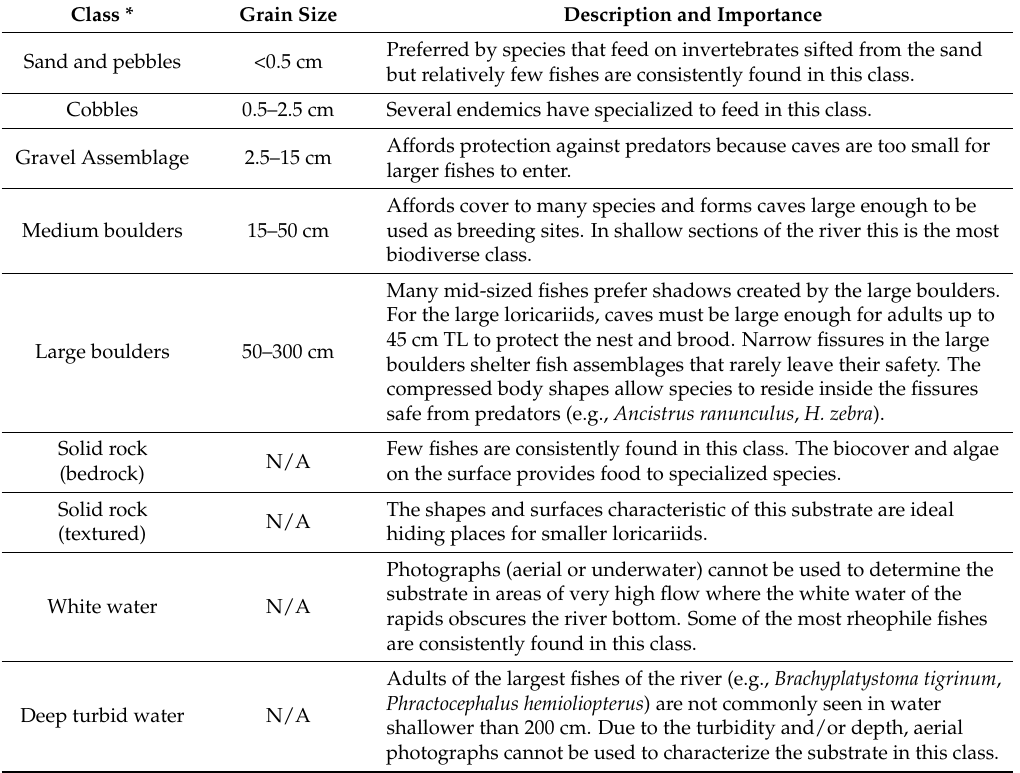
Table 1. Summary of the nine habitat classes important for Xingu fish diversity.